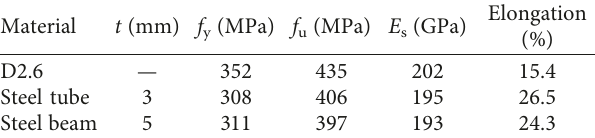
Table 4: Summary of Structural characteristics of the tested